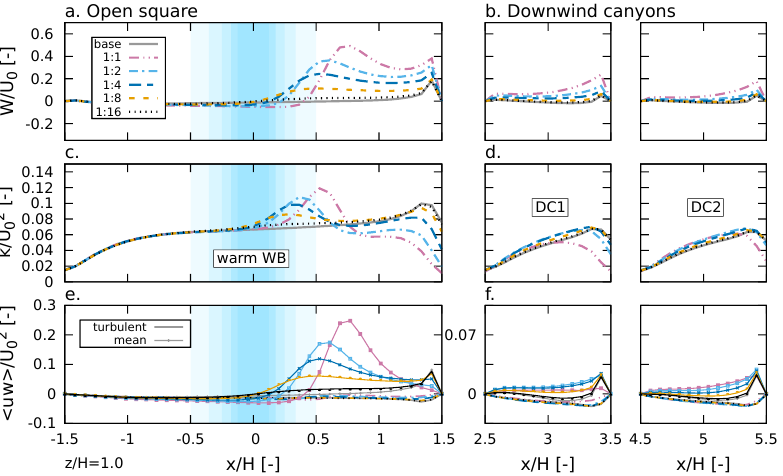
Figure 13. Profiles of non-dimensional ( a , b ) vertical velocity ( W / U 0 ), ( c , d ) TKE ( k / U 02 ) and ( e , f ) ver- tical flux budget ( (cid:104) uw (cid:105) / U 02 ) over a horizontal line at roof level ( z / H = 1) across the domain’s centre line ( y / H = 0) for the warm water body cases and different sizes. Results for ( a , c , e ) the open square and ( b , d , f ) the downwind canyons; In panels ( e , f ), single lines denote mean values, whilst lines with points denote turbulent